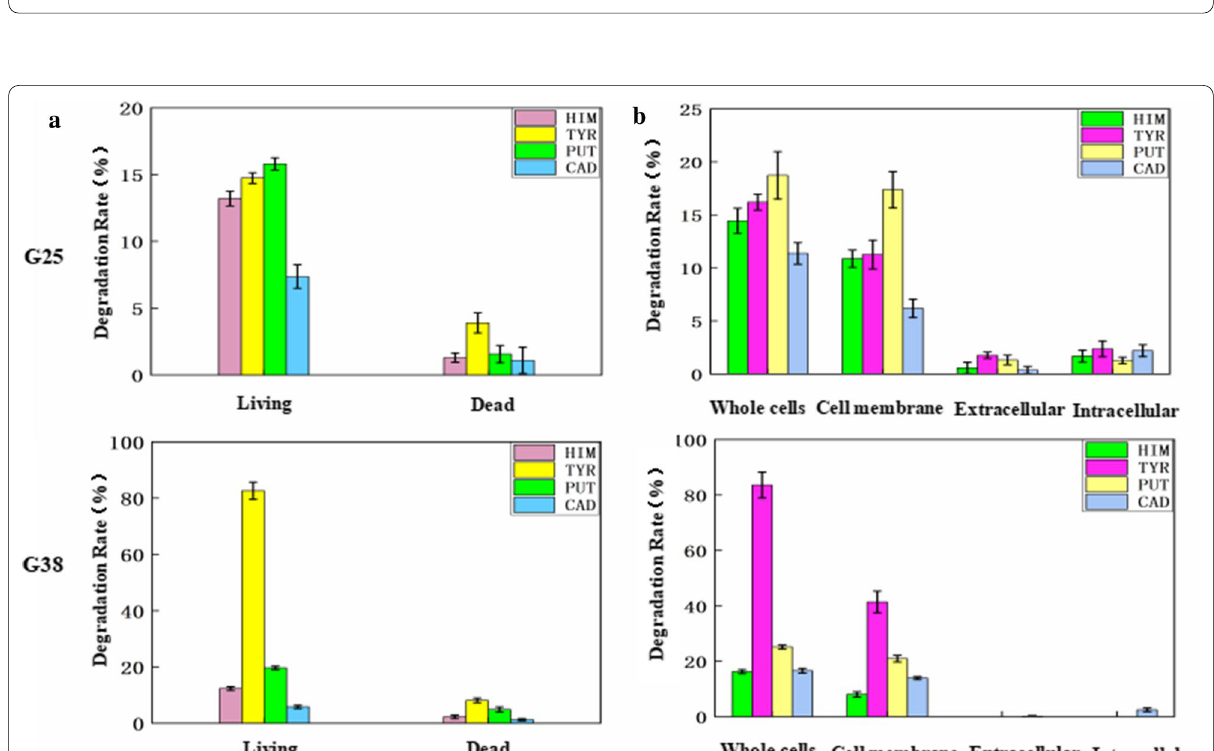
Fig. 2 Degradation of BAs under different conditions, data are the means b Temperature. c pH. d Ethanol concentration